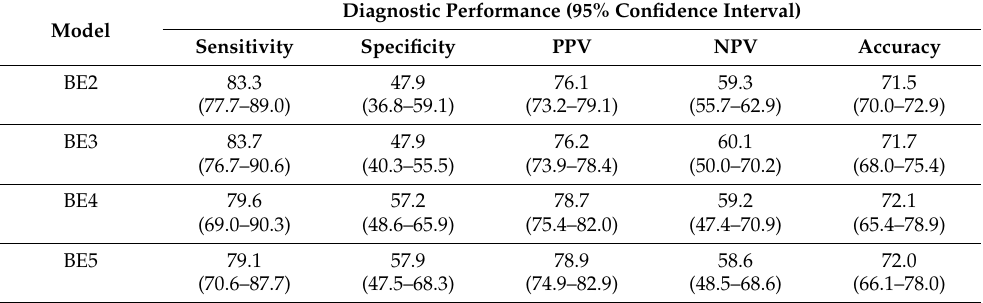
Table 2. Diagnostic performance of ensemble deep learning models for identifying Pseudomonas keratitis in bacterial keratitis.